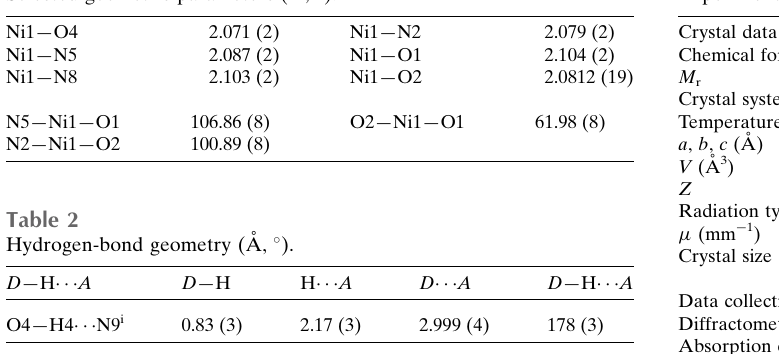
Table 3 Experimental details.